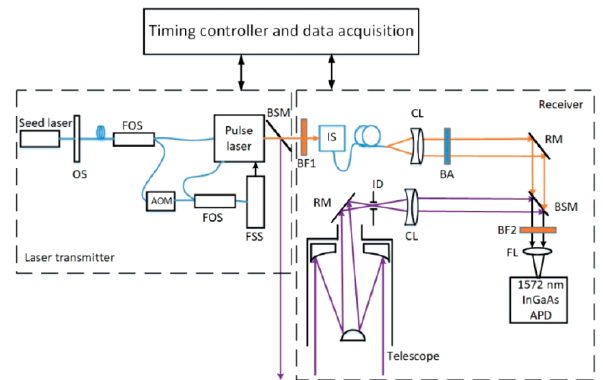
Figure A1. Schematic diagram of the IPDA lidar system [25]. This block diagram comes from the study of Zhu et al. 2019.